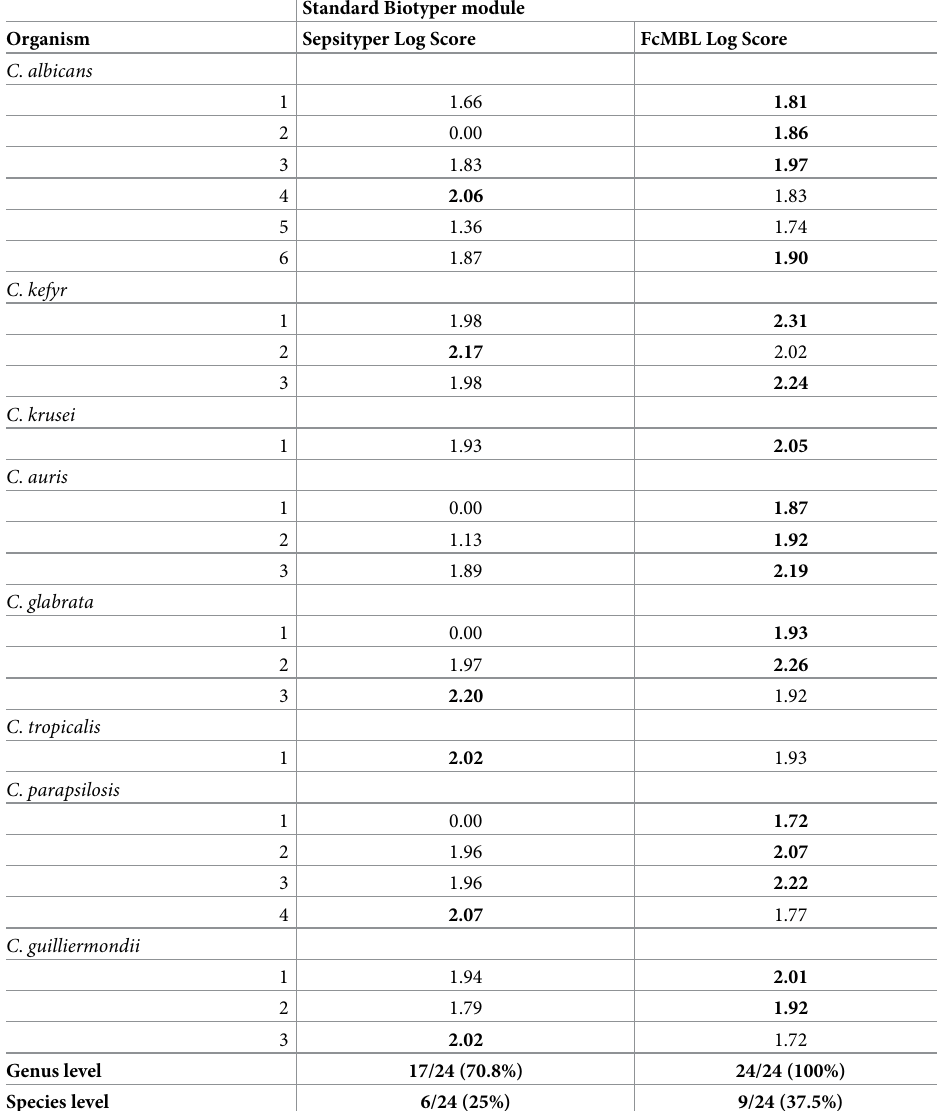
Table 3. Comparison of Bruker Biotyper log scores between the Sepsityper 1 and FcMBL rapid identification methods for fungemia. Log scores highlighted in red indicate scores below identification confidence. Bold log scores indicate the higher score of the two